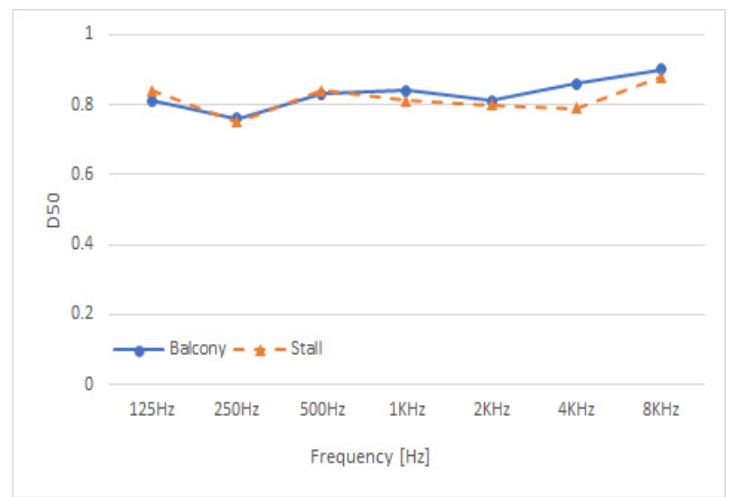
Figure 11. Measurements results of the Definition (D 50 ).